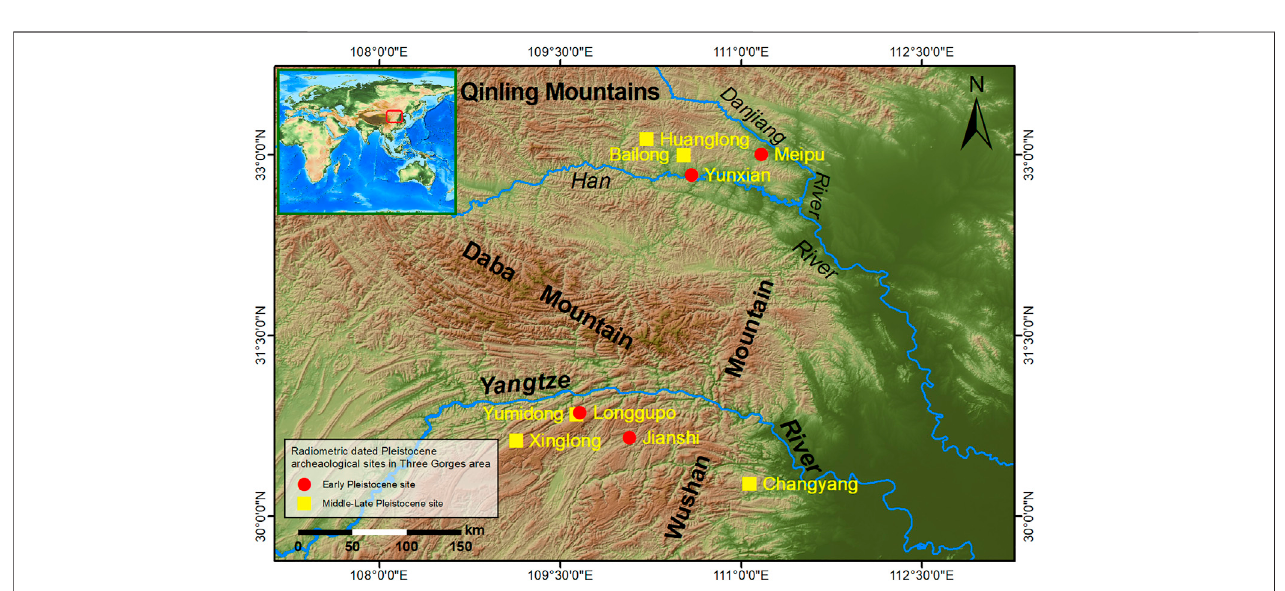
FIGURE 2 | Location map of the hominin settlement sites in the Three Gorges region mentioned in the text.